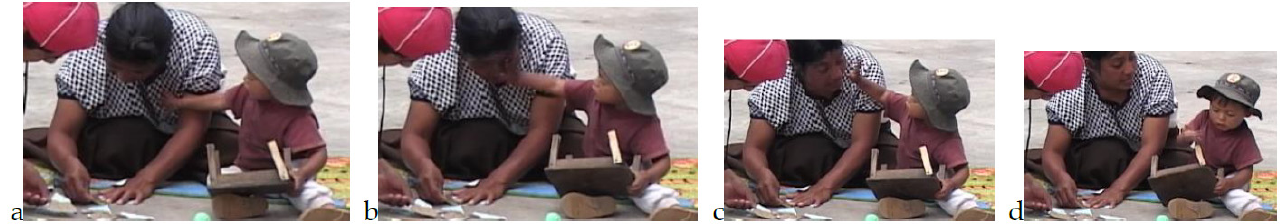
Figure 17. Vic at 22 mos. grabbed his mom’s face to comment on a broken table leg. ( a , b ) Vic touches his mother’s face, ( c ) to secure her gaze before ( d ) signing a comment, here about a broken table leg.